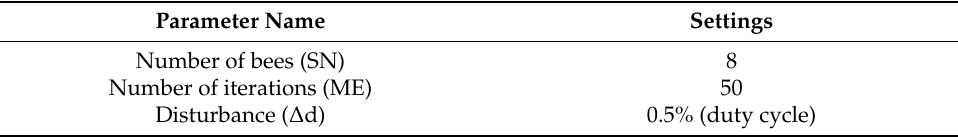
Table 3. Parameter settings of the I-ABC